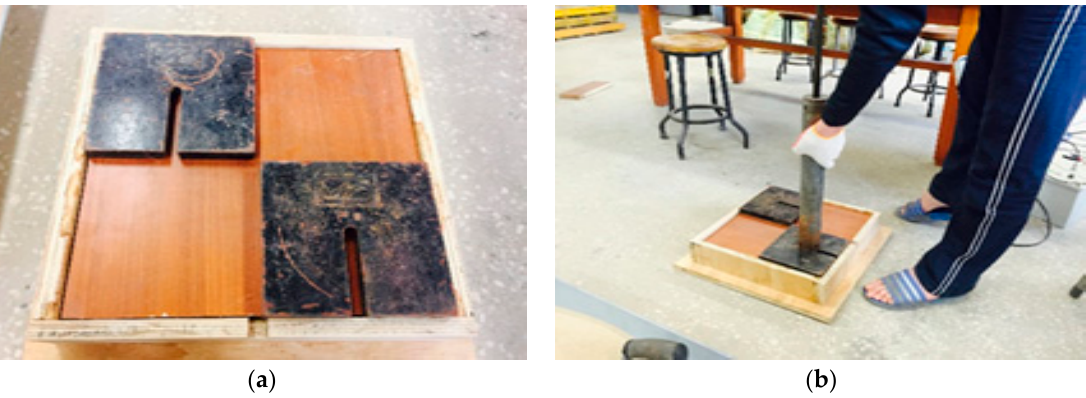
Figure 16. Compaction process. ( a ) Preparation of soil compaction with weight; ( b ) Compaction.